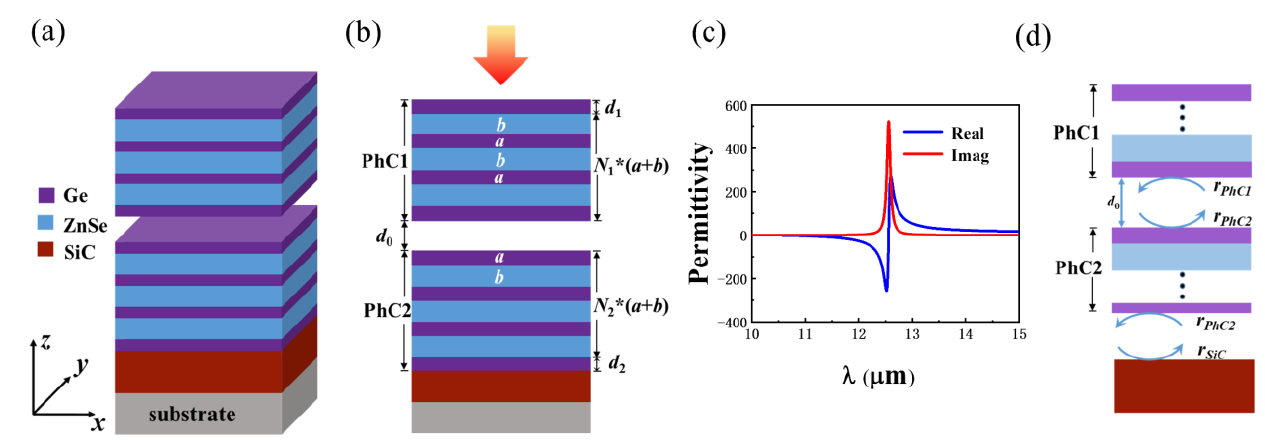
Figure 1. ( a ) Schematic diagram of the structure of PhC1-air layer-PhC2-SiC. N 1 *( a + b ) and N 2 *( a + b ) indicate that the number of periodic layers of PhC is N 1 and N 2 , respectively. ( b ) Side view of the structure. ( c ) The dependence of the real part and the imaginary part of the permittivity of SiC on the wavelength. ( d ) The 2D view of the structure used to generate OTS and TPhP.